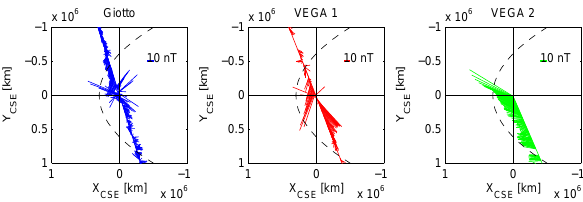
Fig. 3. The orbits of the three close flybys by Giotto (blue), VEGA 1 (red) and VEGA 2 (green) in CSE coordinateswiththemagneticfieldvectorsintheCSE xy -planeplottedalongthespacecraftorbits.